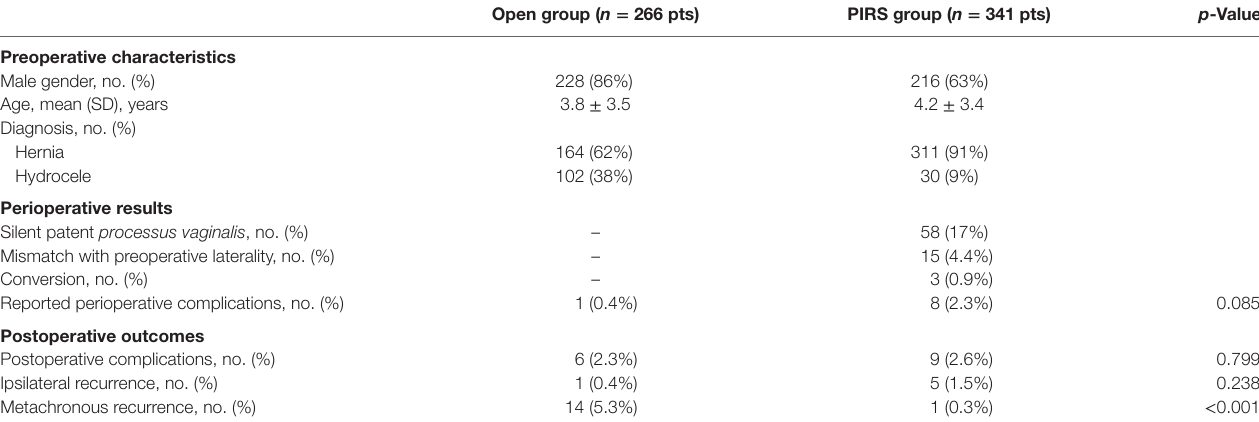
TaBle 1 | Demographic characteristics and clinical outcomes of the open approach (OA) and percutaneous internal ring suturing (PIRS)